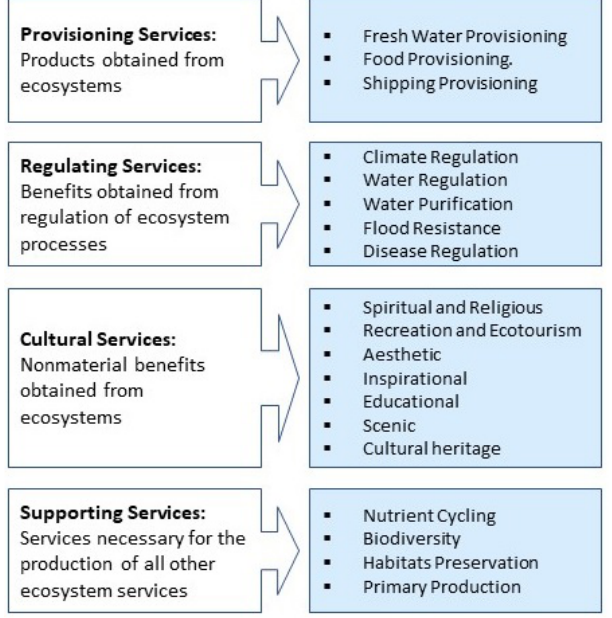
Figure 6. Lake ecosystem services defined by the Millennium Ecosystem Assessment, including provisioning, regulating, supporting, and cultural services.